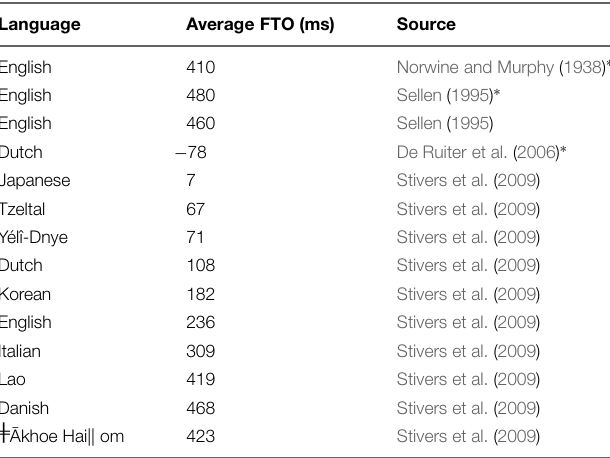
TABLE 1 | Average floor transfer offsets (FTOs) in ten different languages as reported by four different